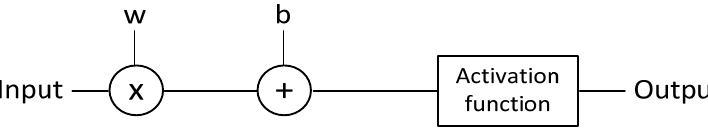
Figure 3. One neuron control logic .